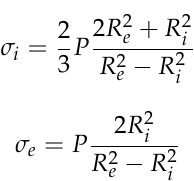
Table 1. Results of the tube strength.